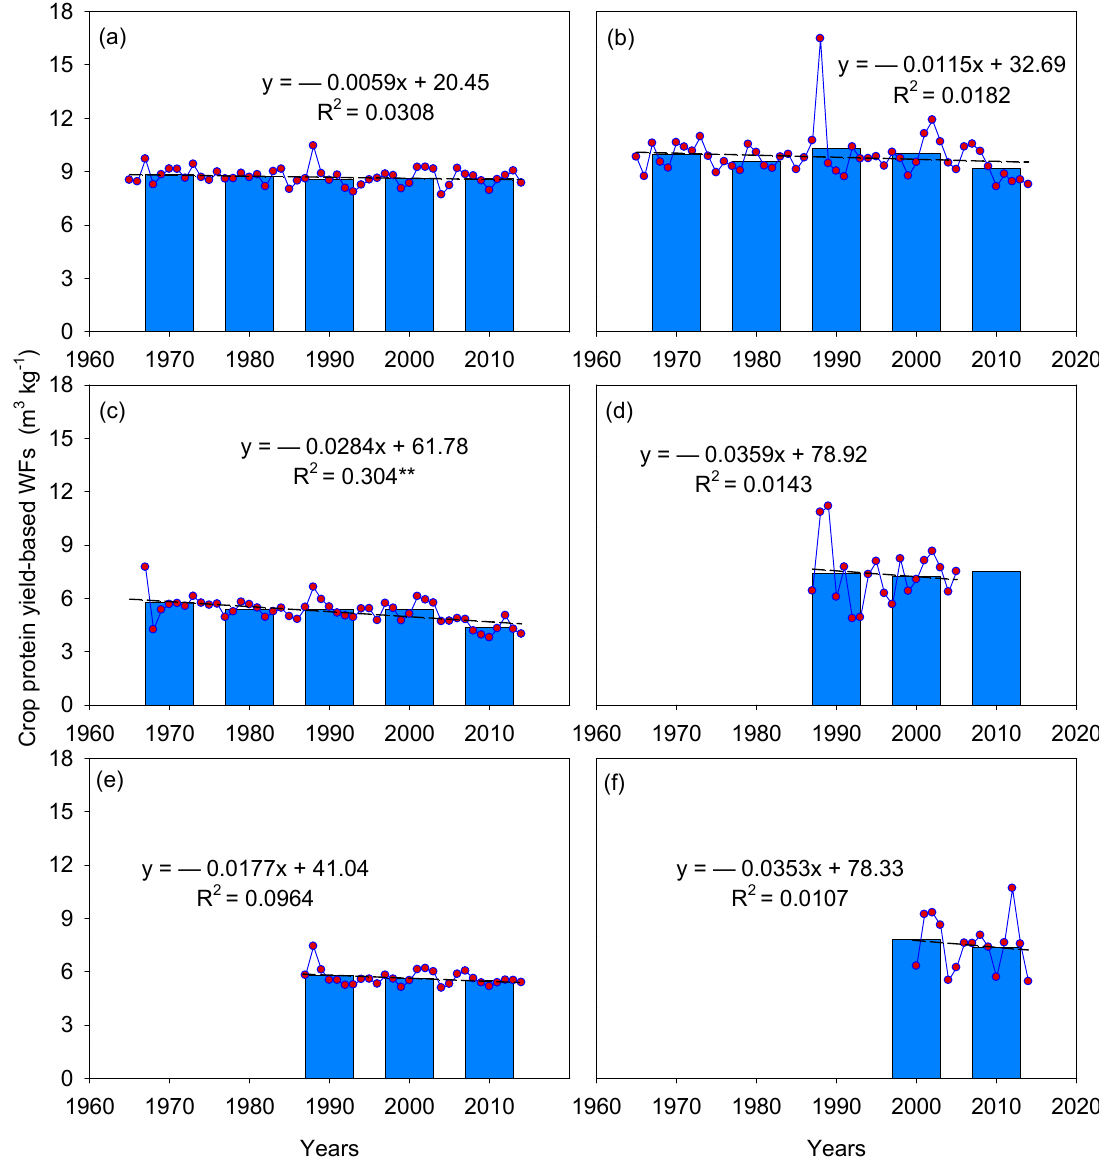
Figure 8. Variations of protein yield-based water footprints (WFs) for six crops in Saskatchewan. The filled dots show the annual protein yield-based WFs and the bars show the decadal average protein yield-based WFs from 1965 to 2014. ( a ) spring wheat; ( b ) barley; ( c ) canola; ( d ) sunflower; ( e ) lentil; ( f ) chickpea. Note: ** Significant difference at 0.01 level.